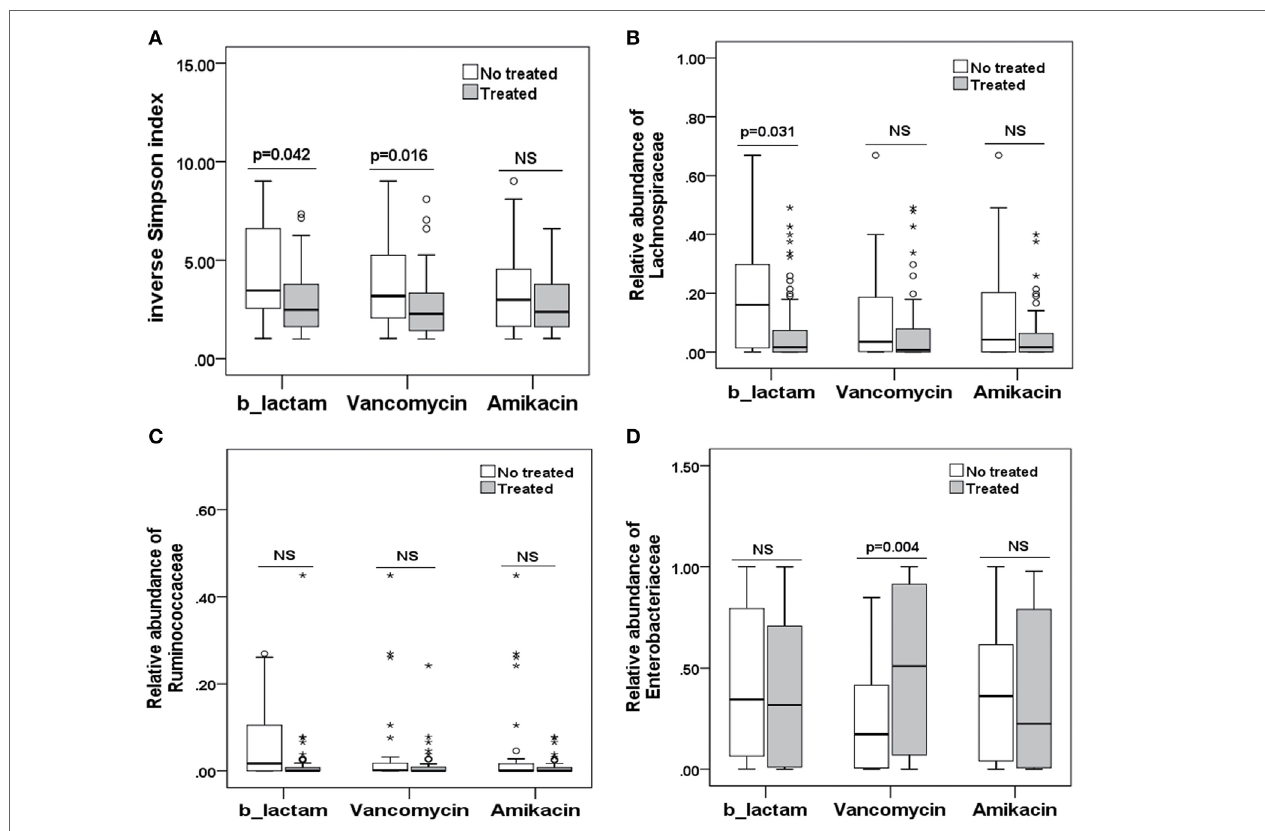
FigUre 4 | Differences in the intestinal microbiota (diversity and composition) are associated with special antibiotic administration in allo-HSCT patients. (a) Differences in microbiota diversity, (B) relative abundance of the Lachnospiraceae, (c) Ruminococcaceae, and (D) Enterobacteriaceae families under different antibiotics. b-lactams, include carbapenems, cephalosporins, and b-lactam-b-lactamase